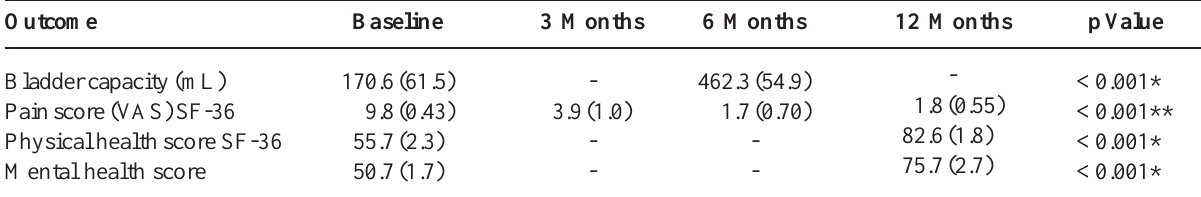
Table 1 – Baseline and follow up data on bladder capacity, pain score and SF36 score, mean